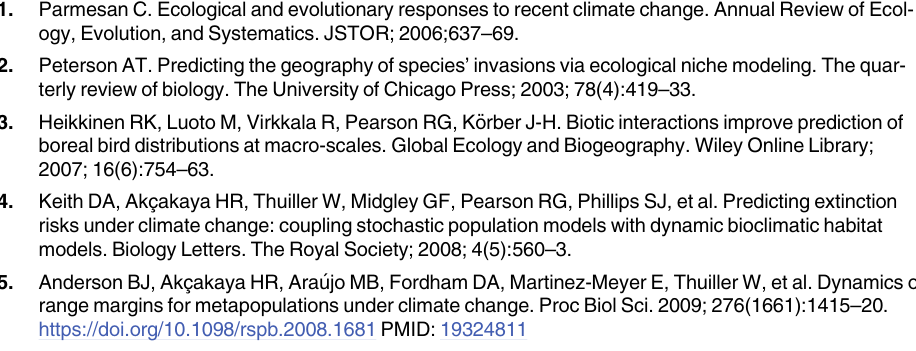
S3 Table. Links. Summary for all the significant links inferred between species. Species involved (from: parent node, to: children node), strength and direction of the association based on the number of times that the link appears in the resampled networks, sign and signifi- cance of the sign based on the Jonckheere trend test and the syndrome code for the interspe- cific